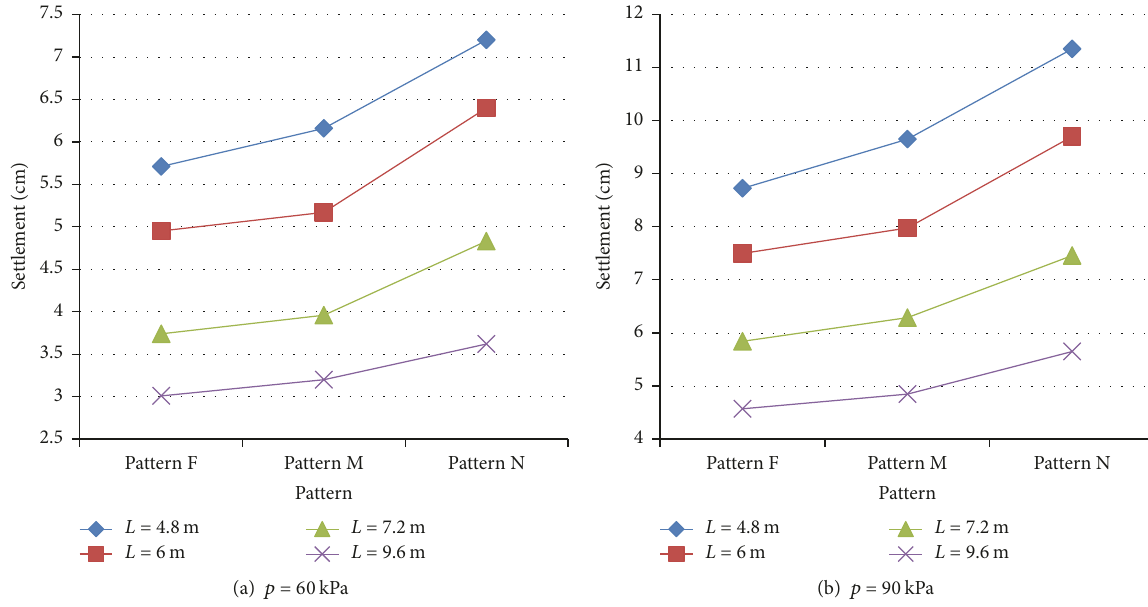
Figure 14: Effect of axial load on the coupled static-dynamic settlements of CPRF ( 𝑑 = 0.5 m, 3 ∗ 3 architecture).